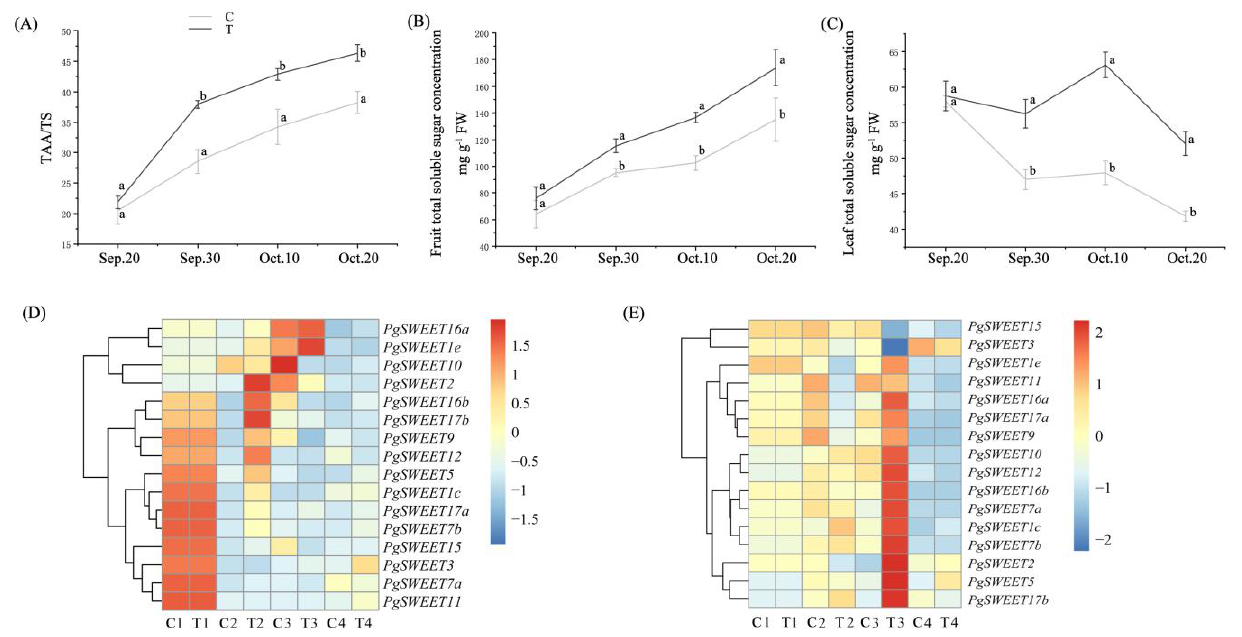
Figure 4. Changes in TSS/TA of fruit ( A ), total soluble sugar concentration of fruit ( B ), total soluble sugar concentration of leaf ( C ), SWEETs expression of fruit ( D ) and SWEETs expression of leaf ( E ) during fruit growth and development after pure water (C, control) and tripotassium phosphate (T, treatment). Each value is the mean for three replicates, with vertical bars representing standard errors. The different letters at each time point show significant differences ( p < 0.05) using Duncan’s tests between control and treatment. In ( D , E ), numbers 1 – 4 represent dates from 20 September to 20